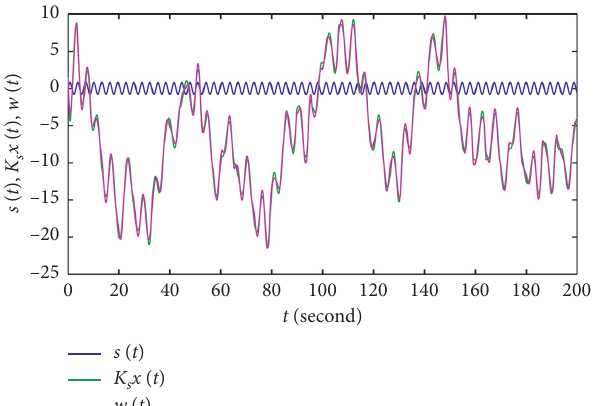
Figure 11: State trajectories of encrypted signal s ( t ) and decrypted signal 􏽢 s ( t ) with T c � 0 . 2.